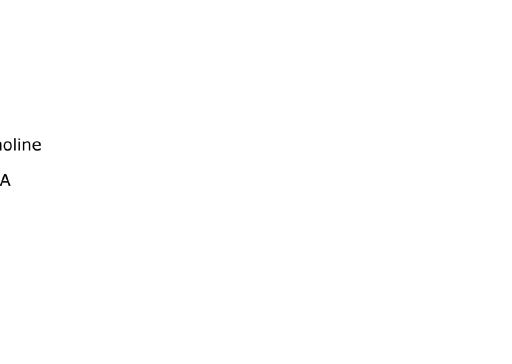
Figure 5. Plasma choline and LPA levels under fasting and fed states. The plasma choline (red) and LPA (blue) levels before and after meals (n = 5) were determined. The data show the percentage change from the value measured before the first meal (mean ± SD). The arrows indicate food intake. * P < 0.05, differences between before and after